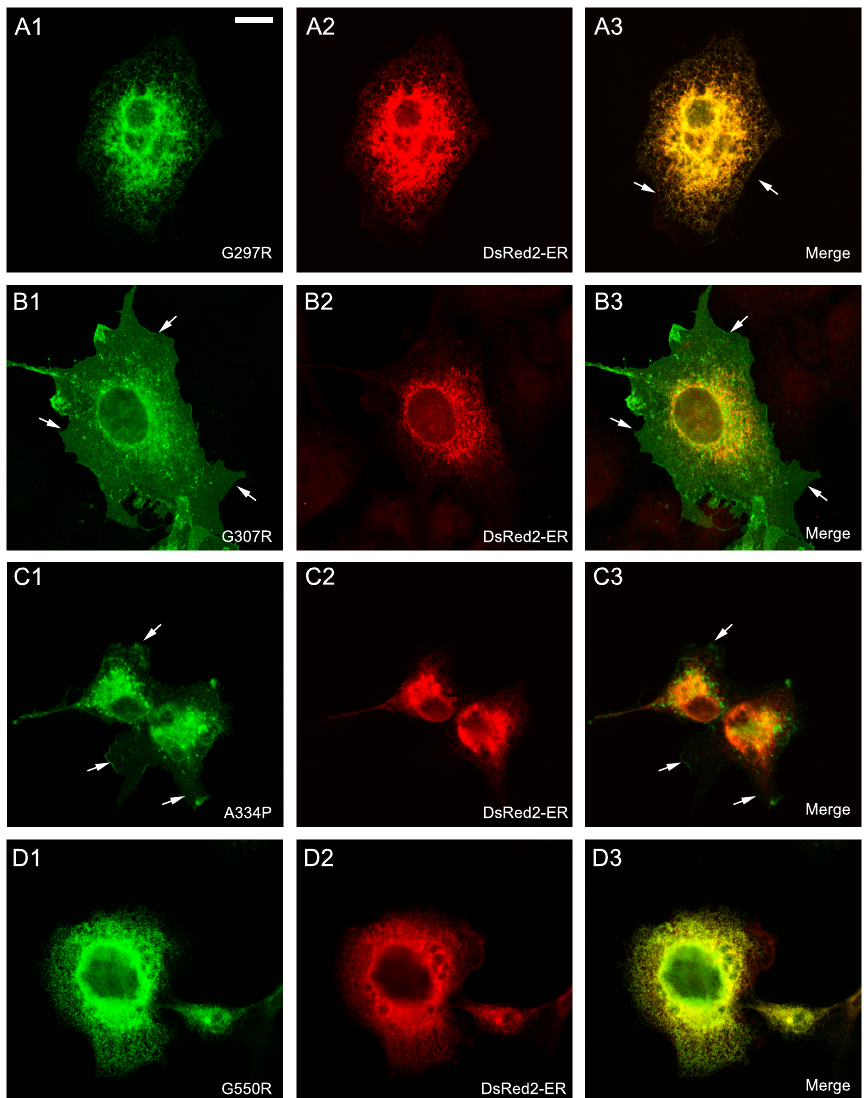
Figure 5. Subcellular distribution of GAT-1 variants in transfected cells. COS7 cells were transfected with expression vectors for the indicated HA-tagged mutants: G297R ( A1 – A3 ); G307R ( B1 – B3 ); A334P ( C1 – C3 ); G550R ( D1 – D3 ). Transfection mixture also contained the expression vector for